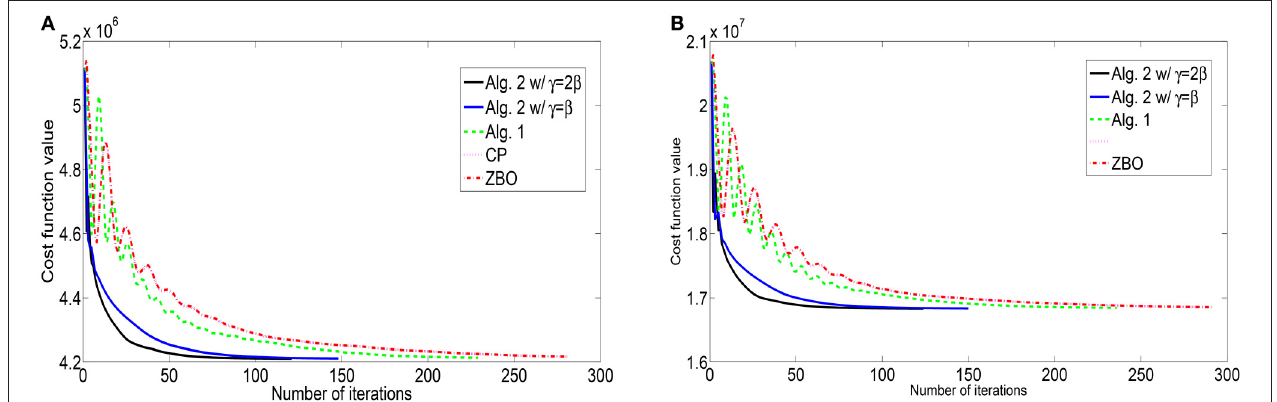
FIGURE 5 | Evolutions of function values of the L1-TV model for images of (A) “Cameraman” and (B) “Lena.”